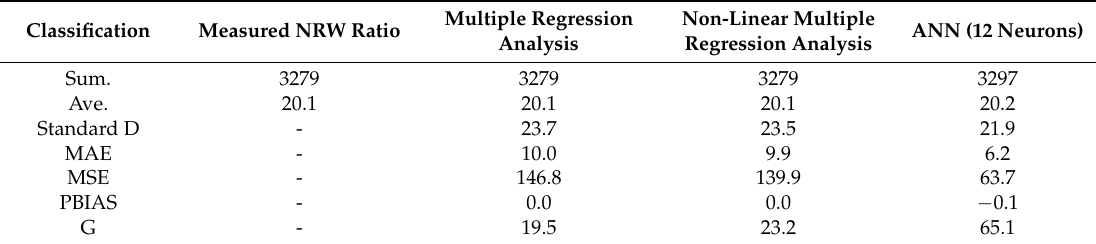
Table 5. Results of Accuracy Assessment. Mean absolute error (MAE); mean squared error (MSE); percent of bias (PBIAS); goodness of fit